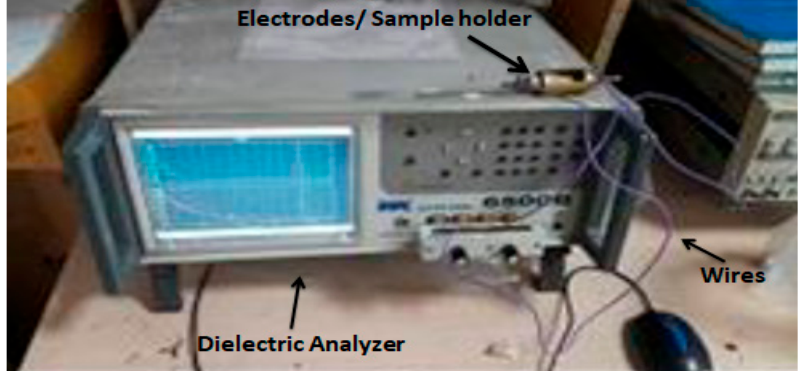
Figure 1. Picture of Dielectric Analyzer (WK 6500) Measurement Setup.